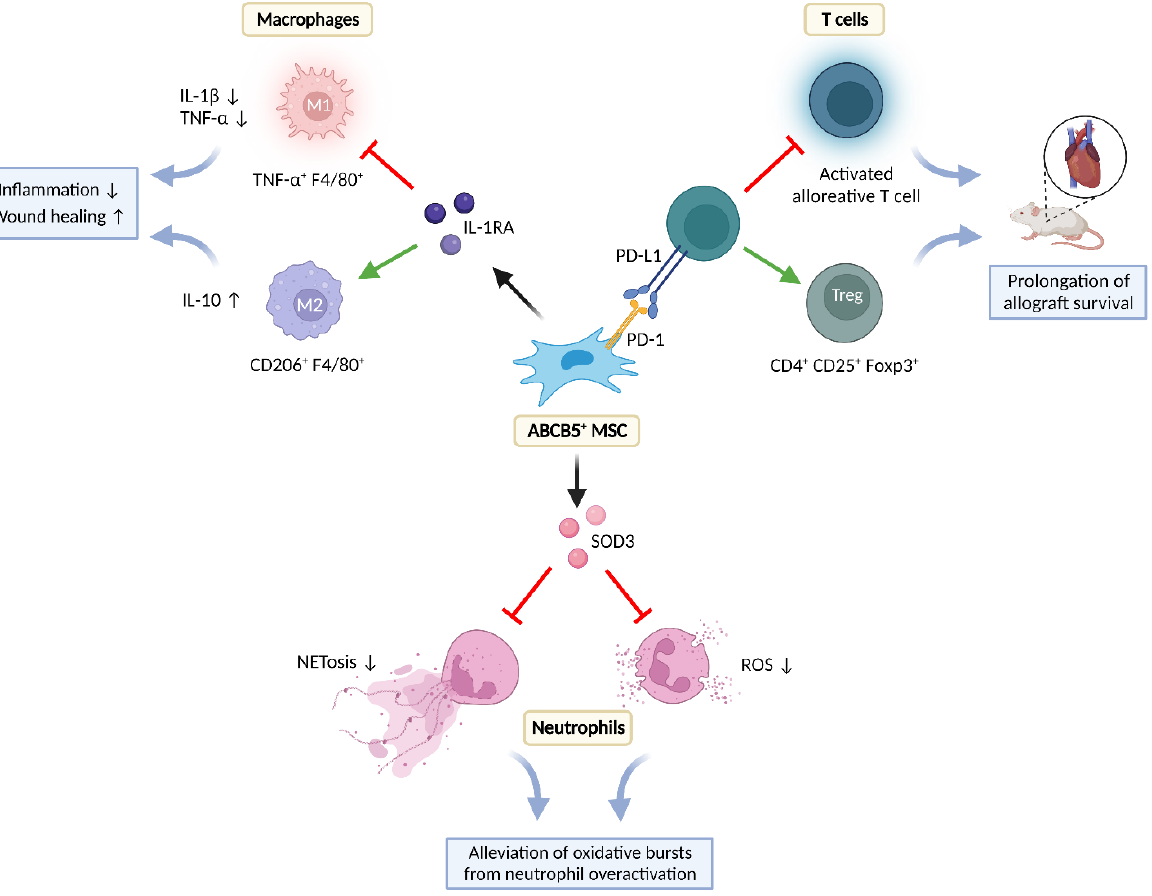
Figure 3. Immunomodulatory interactions of ABCB5 + MSCs with T-cells, macrophages, and neutrophils in inflamed environments. Foxp3 — forkhead box protein P3; IL — interleukin; IL-1RA — interleukin 1 receptor antagonist; NET — neutrophil extracellular trap; PD-1 — programmed cell death protein 1; PD-L1 — programmed cell death ligand 1; ROS — reactive oxygen species; SOD3 —